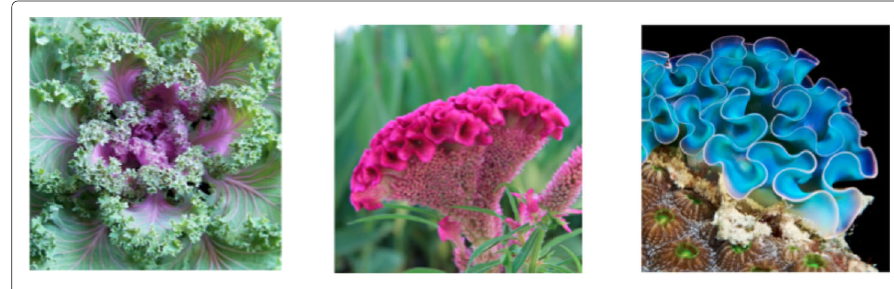
Fig. 1 Examples of naturally occurring non-Euclidean elastic sheets